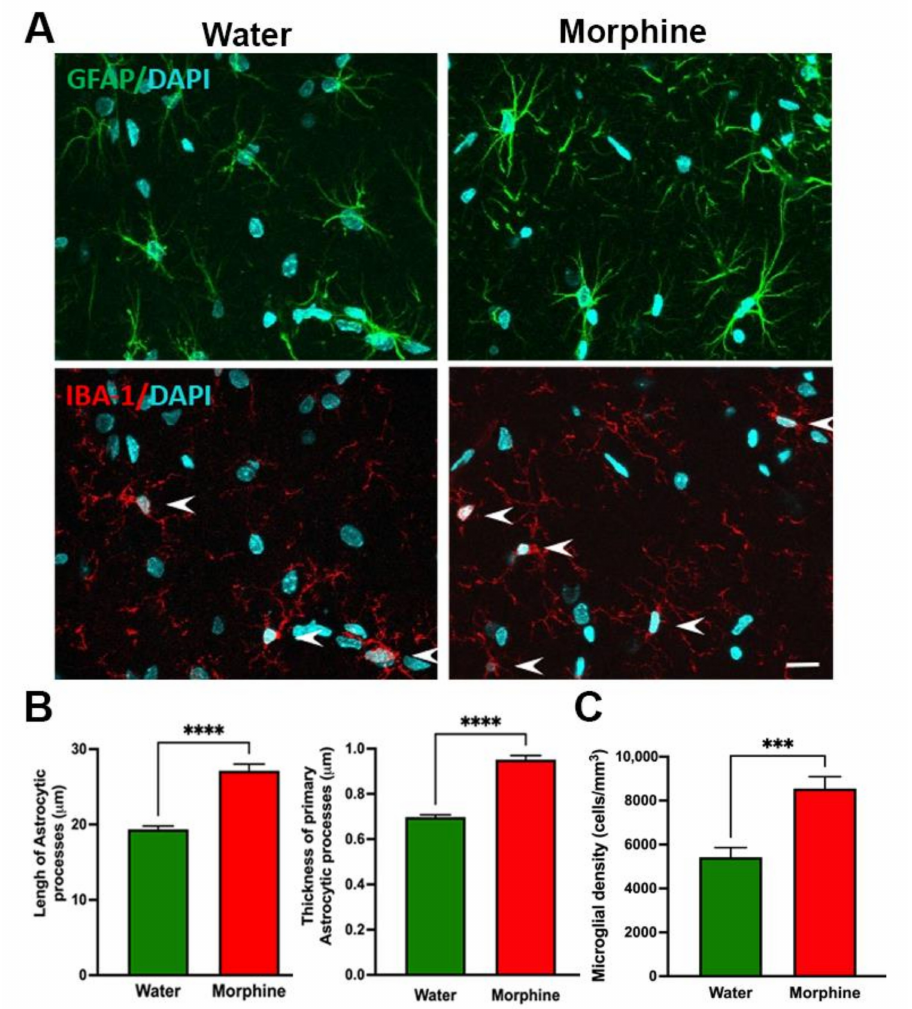
Figure 6. Voluntary morphine intake induces hippocampal neuroinflammation in Wistar rats. ( A ) Rep- resentative confocal microphotographs of hippocampal astrocyte GFAP immunoreactivity (green, top) and microglial density (Iba-1, red, shown by arrows, bottom) double-labeling immunoreactivity of rats which had voluntarily drank morphine solution (15–18 mg/kg/day) for four weeks. Animals drinking only water were used as controls. Nuclei were counterstained with DAPI (blue, nuclear marker), scale bar 25 mm. ( B left) Quantification of total length and ( B right) thickness of primary astrocytic process and ( C ) Quantification of microglial density evaluated by confocal microscopy and FIJI image analysis software. Data are expressed as mean ± SEM. n = 8 in each experimental group. *** p < 0.001, **** p < 0.0001, two-tailed Student t